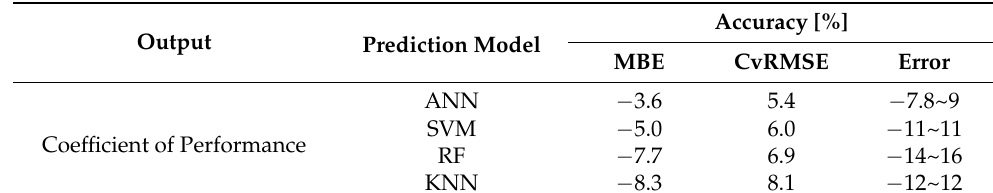
Figure 5. Comparison of predicted and measured performance using ANN model. Table 8. Accuracy of prediction model.